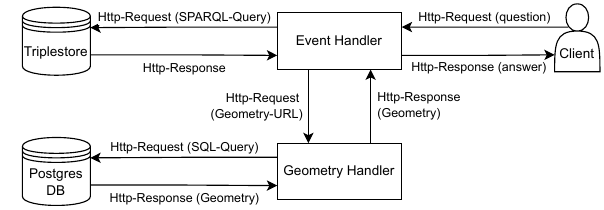
Figure 4. Communication for answering a clients question.